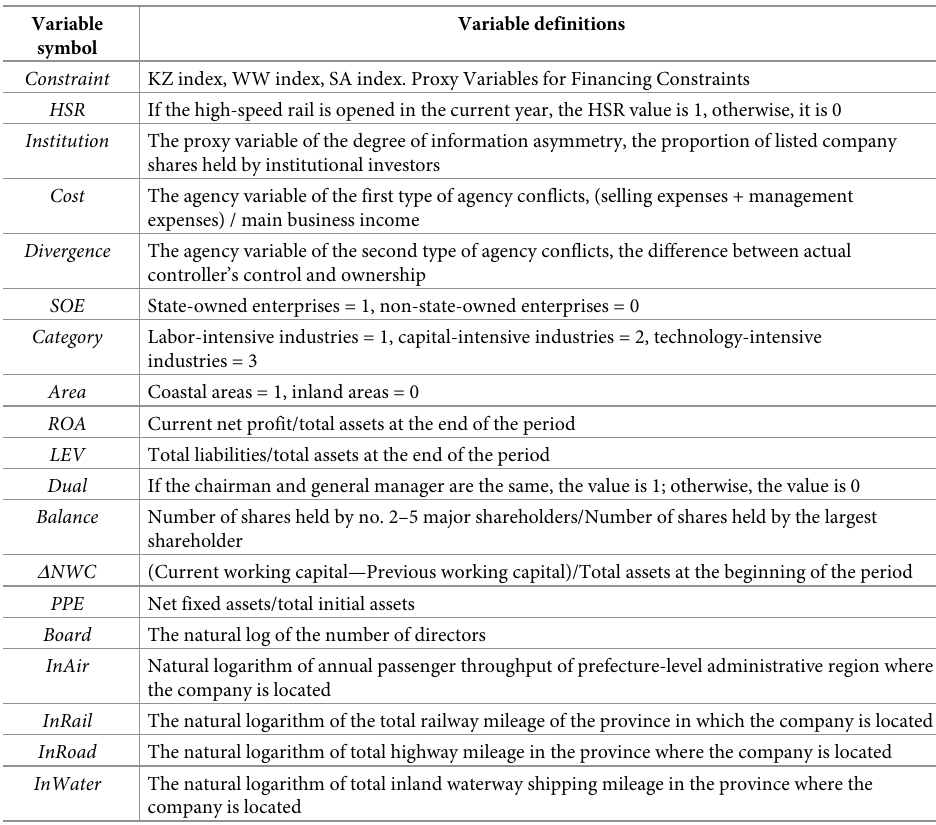
Table 1. Description of main